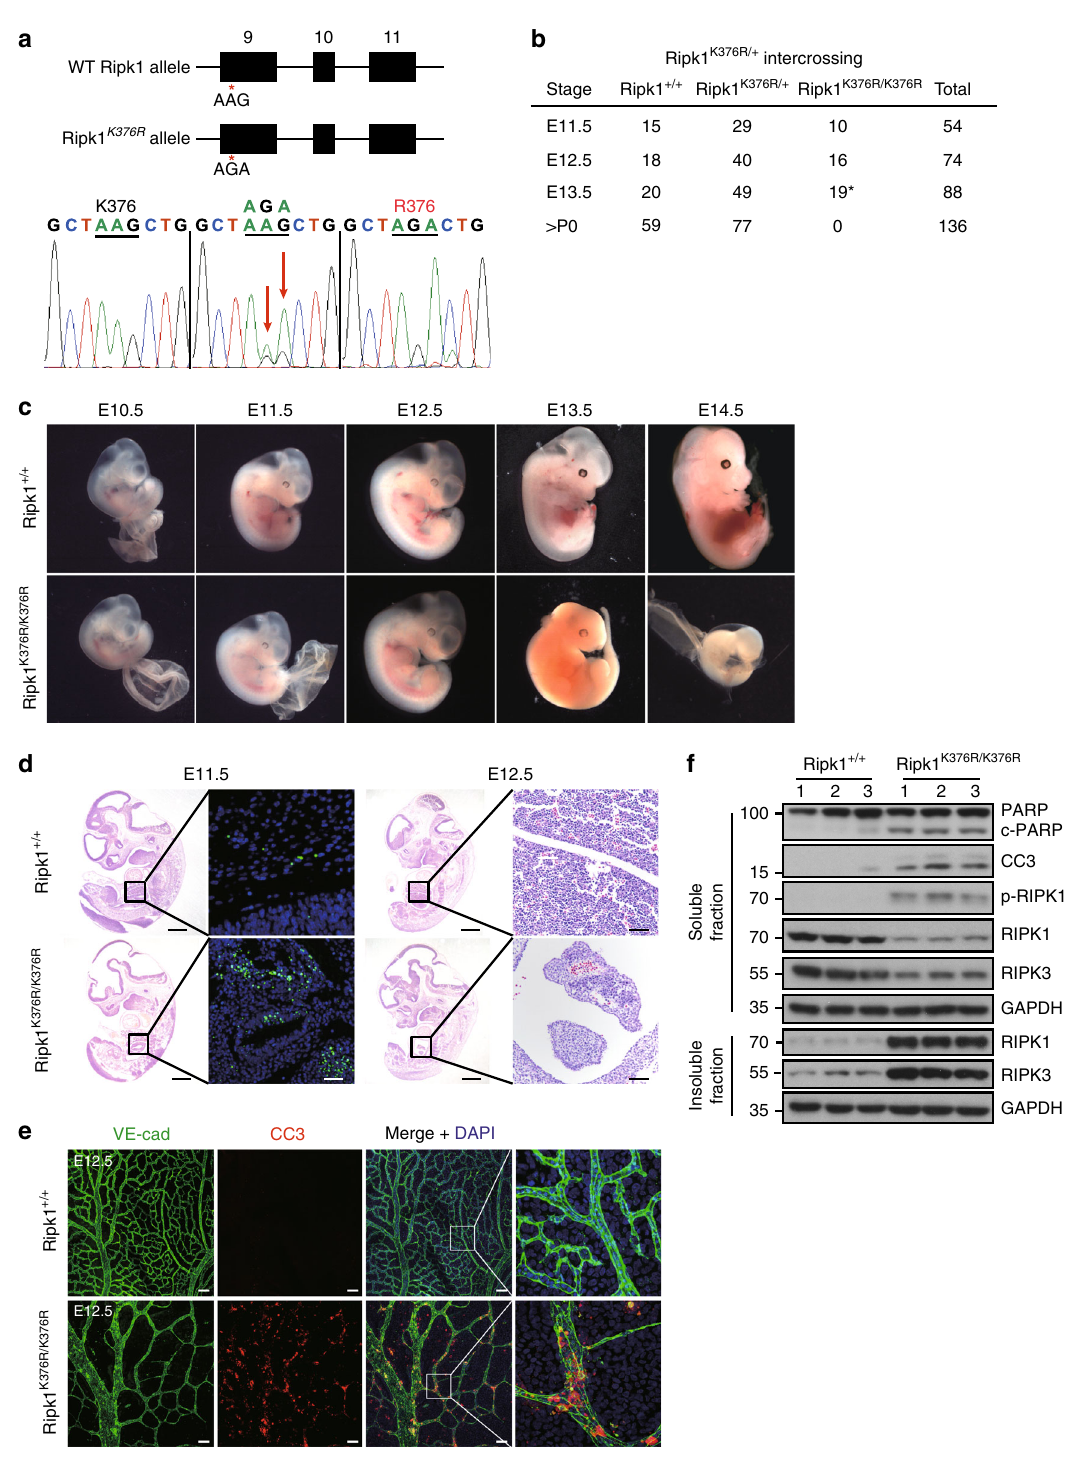
Fig. 1 Ripk1 K376R/K376R mice die during embryogenesis. a Organization of the Ripk1 K376R mutant allele. Lysine (AAG) was mutated to Arginine (AGA) at the 376 position in RIPK1. The mutation was con fi rmed by sequencing. b Observed numbers of embryos or live born pups of the indicated genotypes at various developmental stages from Ripk1 K376R/ + mice intercrosses. Asterisk indicates the abnormal embryos. c Whole-mount dark fi eld images of embryos with indicated genotypes. Images are representative of embryos from E10.5 ( n = 5), E11.5 ( n = 10), E12.5 ( n = 16), E13.5 ( n = 19), E14.5 ( n = 5). d Representative Hematoxylin and eosin (H&E)-stained and TUNEL-stained fetal livers from mouse embryos of the indicated genotypes (Scale bars, 1 mm). Images are representative of fetal livers from wild-type ( n = 3) and Ripk1 K376R/K376R ( n = 3). Scale bars, 50 μ m. e Immunostaining for VE-cad (green) and cleaved caspase-3(CC3) (red) on yolk sacs from wild-type and Ripk1 K376R/K376R embryos. Scale bars, 100 μ m. Images are representative of embryos from E12.5 ( n = 3/genotype). f The body samples from E12.5 embryos were analyzed by western blot and immunoblotted for PARP, CC3, p-RIPK1(S166), RIPK1, and